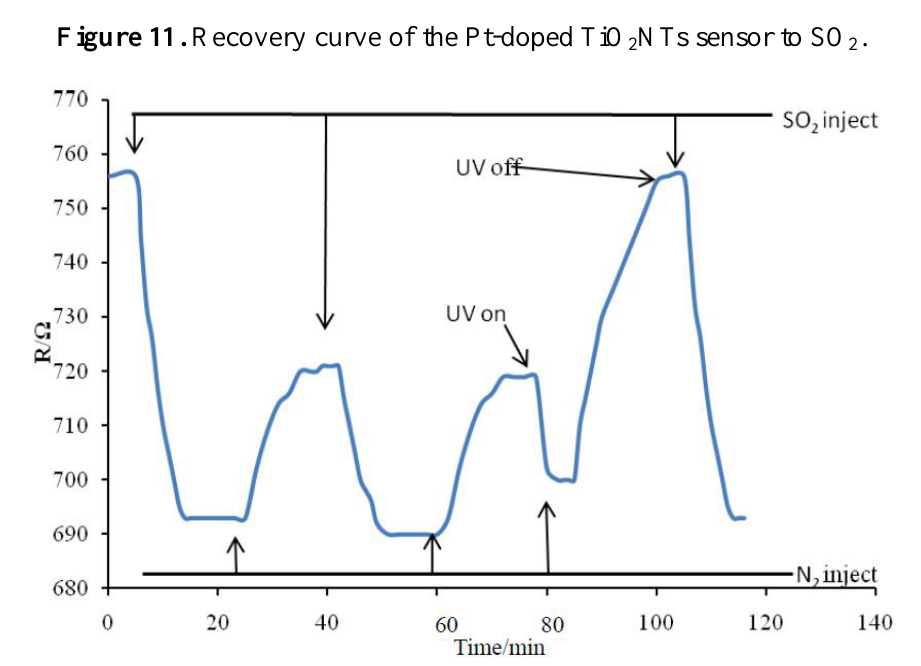
Figure 12. Recovery curve of the Pt-doped TiO